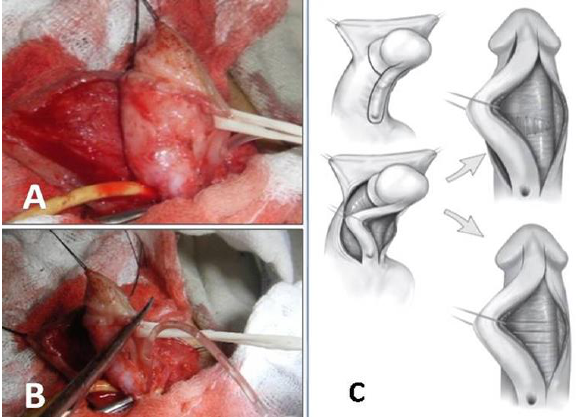
Figure 4: (A) mobilization of urethral plate. (B) urethral plate transection. [(C) ventral corporeal incision with grafting or multiple ventral corporeal incision without grafting (21) ].